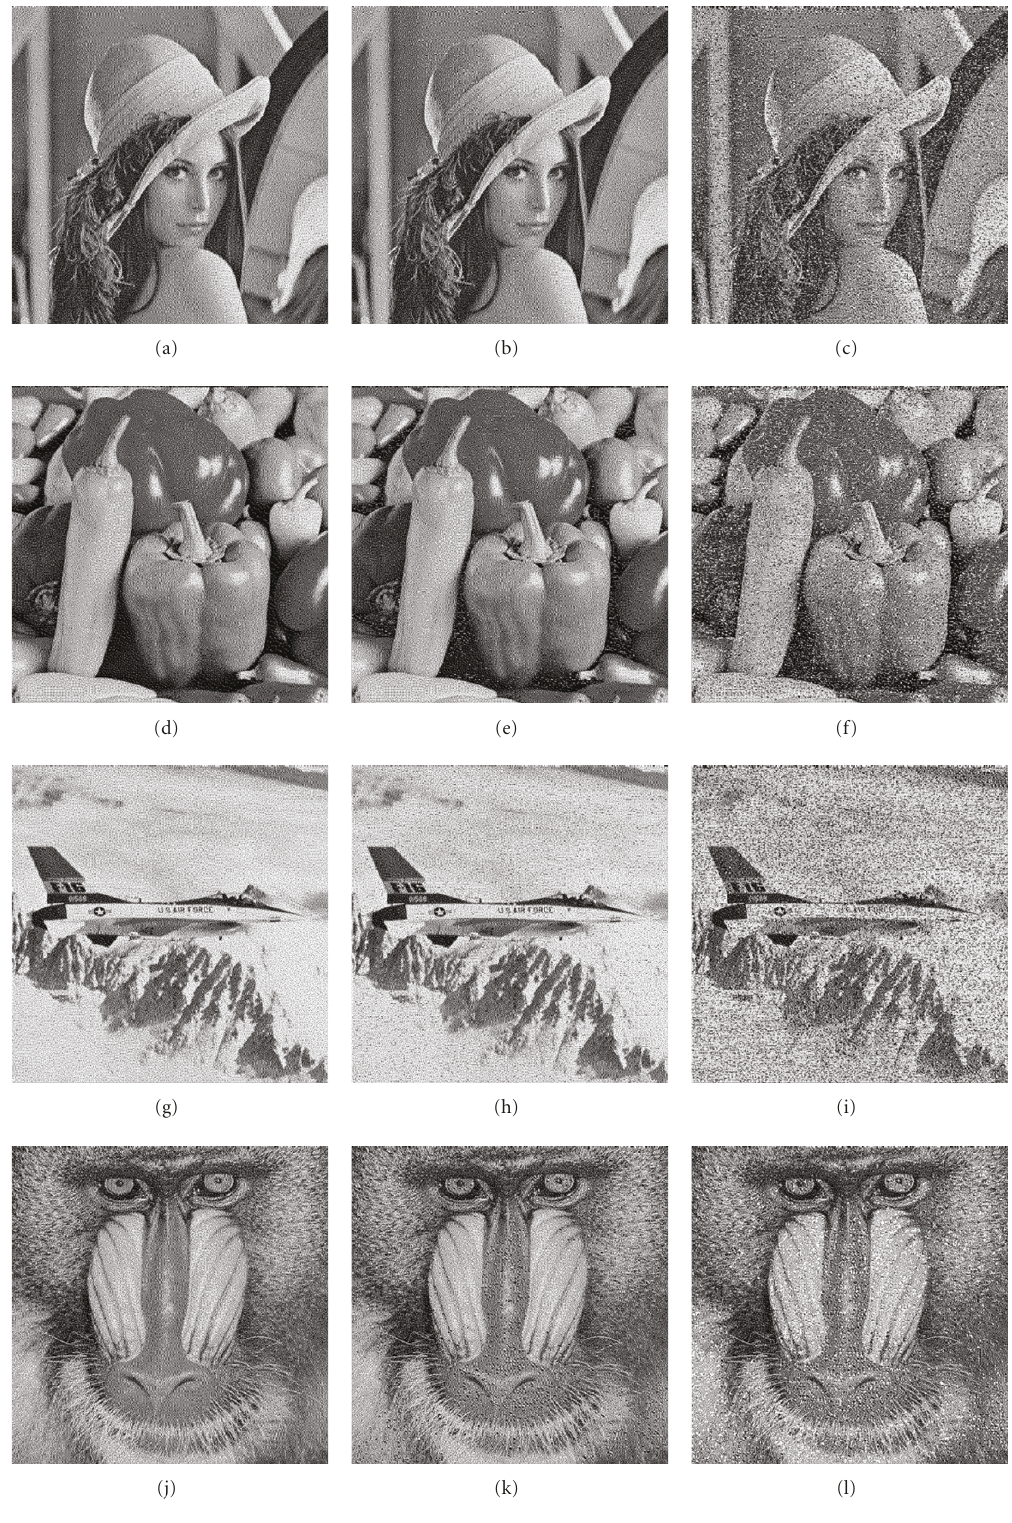
Figure 15: The stego images of data hiding using the proposed method: (a), (d), (g), and (j) the halftone image generated by error di ff usion; (b) and (h) the stego images of embedding two pairs of templates; (e) and (k) the stego images of embedding three pairs of templates; (c), (f), (i), and (l) the stego image of hiding all pairs of